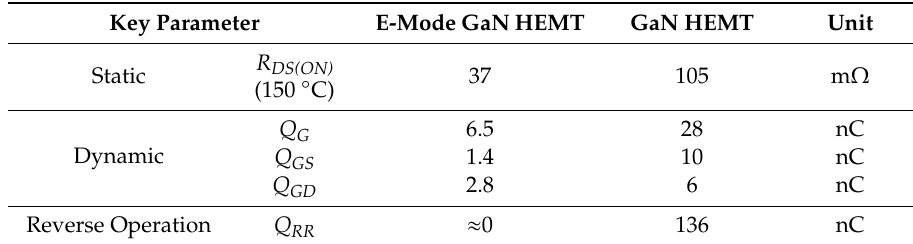
Table 1. The key parameters compare the enhancement-mode gallium-nitride high-electron-mobility transistors (E-mode GaN HEMTs) with the GaN HEMT [12,13]. Key Parameter E-Mode GaN HEMT GaN HEMT Unit R DS(ON) 37 105 m Ω Static (150 ◦ C) Q G 6.5 28 nC Dynamic Q GS 1.4 10 nC Q GD 2.8 6 nC Reverse Operation Q RR ≈ 0 136